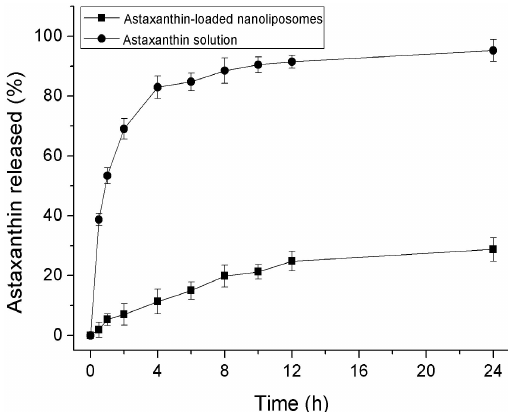
Figure 5. In vitro release of astaxanthin from astaxanthin solution and nanoliposomes in PBS (pH 7.4) at 37 ◦ C. Data are represented as the mean ± standard deviation ( n =